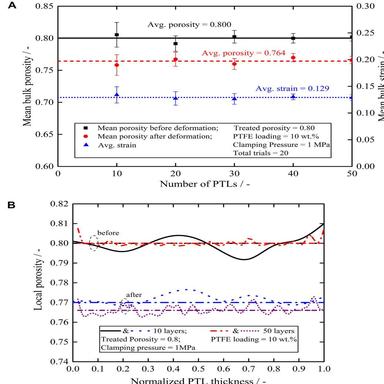
(a) Statistically estimated bulk mean porosity before and after the external stack compression and (b) microscopic local variations of the PTLs porosities for 10 and 50 layers, respectively.